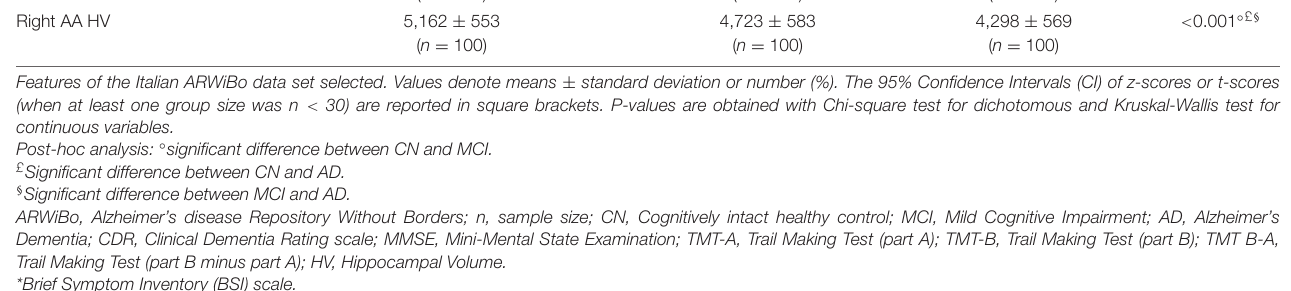
TABLE 5 | Mean hippocampal volume percentiles of the ARWIBO cohort.